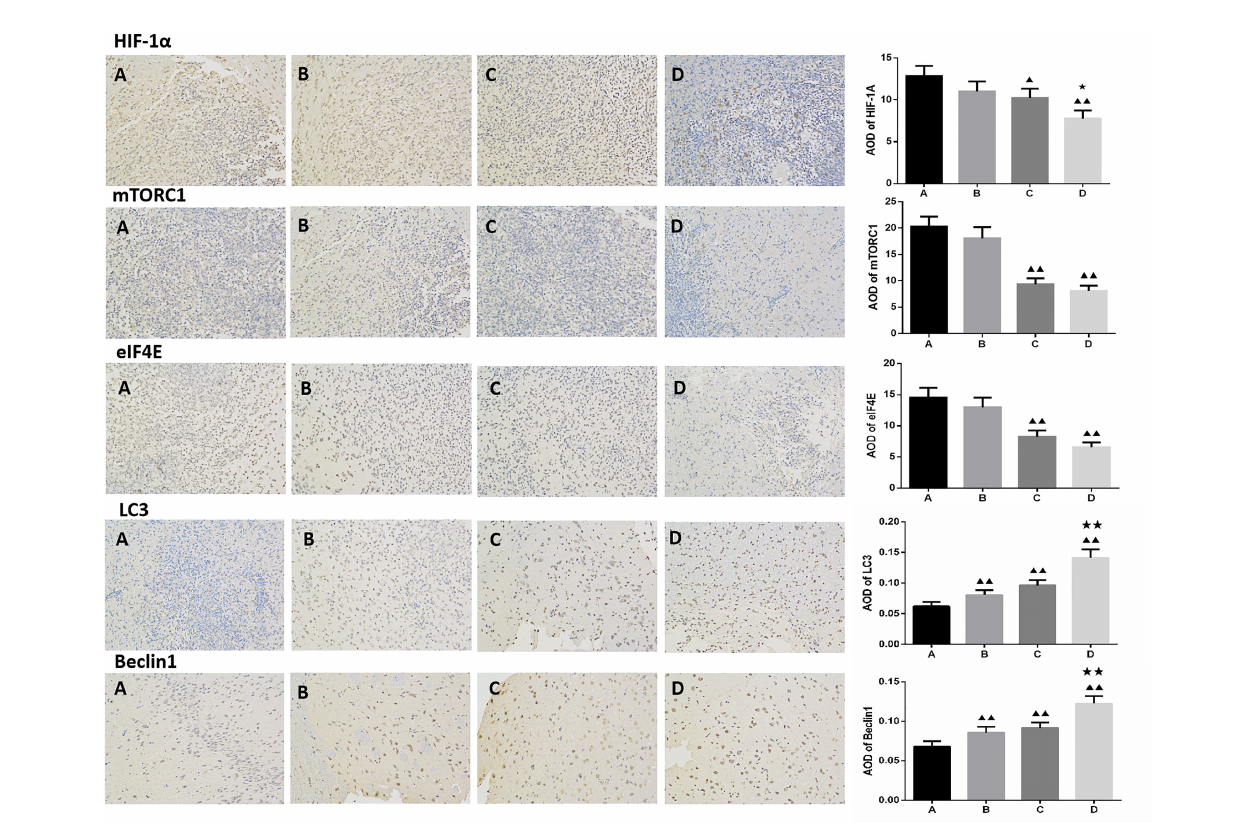
FIGURE 2 | Immunohistochemical detection of HIF-1 a , mTOR, eIF4E, LC3 and Beclin1 expression levels in glioma tissues treated by borneol and radiotherapy (n=3, ×200 times). (A) Control group (B) Borneol 16mg/Kg (C) Radiotherapy 15Gy group (D) Borneol 16mg/Kg combined radiotherapy 15Gy group. Compared with control group, ▲ P<0.05, ▲▲ P< 0.01; Compared with the radiation 5Gy group, ★ P<0.05, ★★ P<